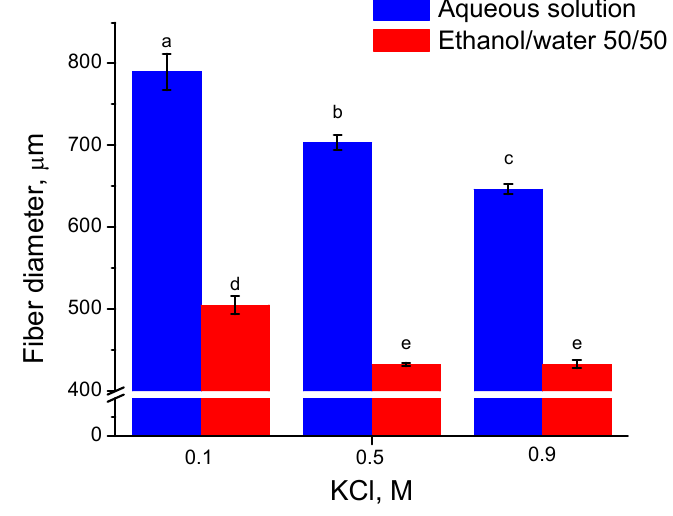
Figure 3. Effect of KCl concentration on as-spun fiber diameters, in either aqueous solution or in ethanol/water (50/50, v/v) mixture (a > b > c > d > e, p <